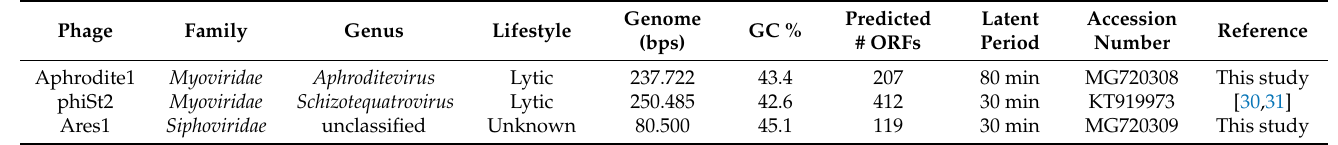
Table 1. Main characteristics of the phages used in this